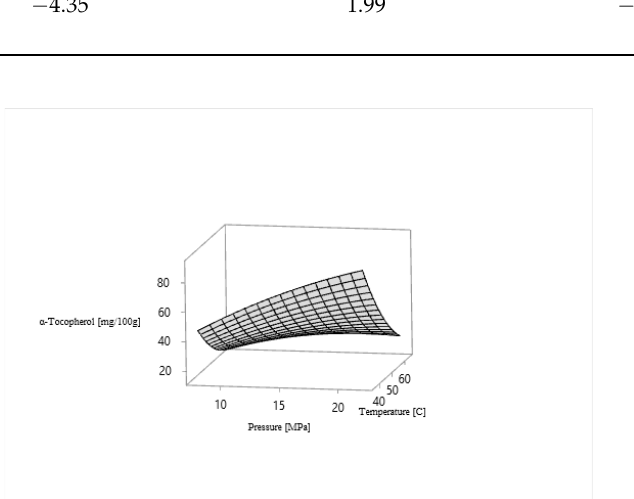
The response surface plot showing the influence of independent variables in coded values on α -tocopherol relative amount is depicted in Figure 2.